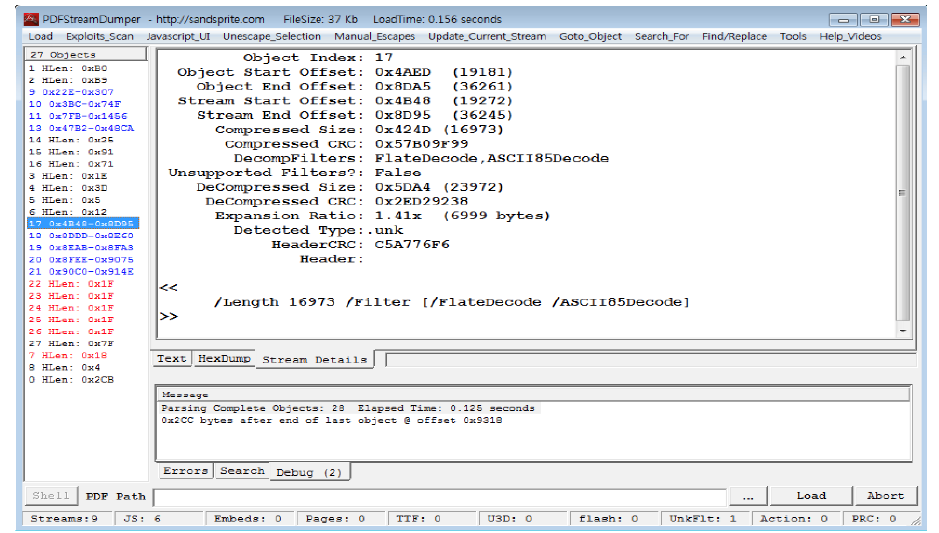
Figure 6 . A malicious PDF file opened by PDFStreamDumper.